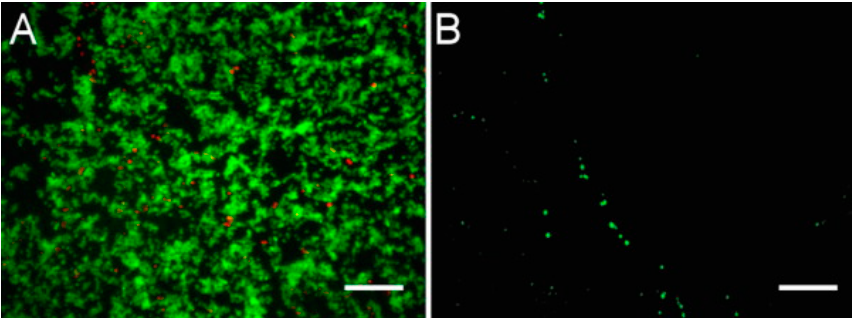
Figure 10. Cell viability assay examination of BHK-21 fibroblast cells at 24 h post-culture on PI2525 polyimide: ( A ) live (viable: green color)/dead (non-viable: red color) staining of cells on the surface of PI2525; ( B ) positive control (latex rubber). Scale bar: 200 µm. Reproduced from [28], with permission from © 2010 Elsevier.